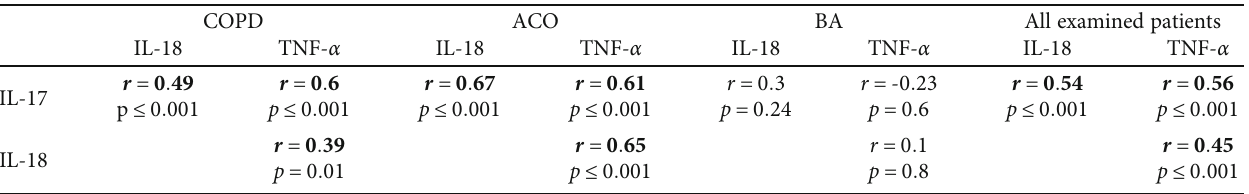
r : correlation coe ffi cient; COPD: chronic obstructive pulmonary disease; ACO: asthma-COPD overlap; BA: bronchial asthma. Table 3: Correlations between the serum concentration of IL-17 and the lung function parameters in patients with COPD, asthma- COPD overlap, and bronchial asthma.